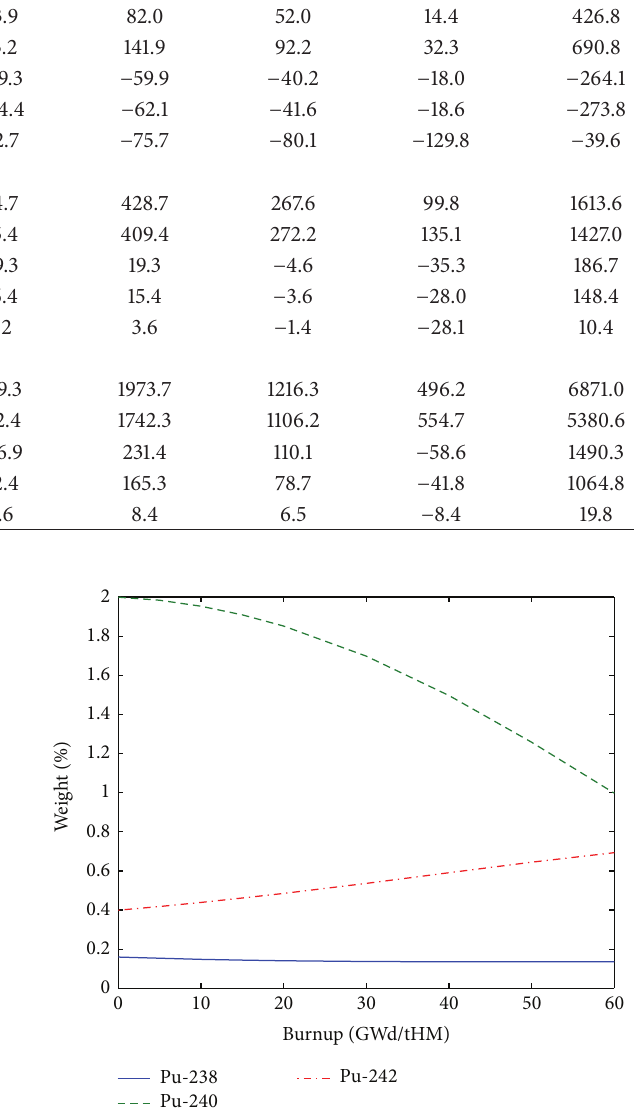
Figure 13: The amount of Pu-238, Pu-240, and Pu-242 in the Th- MOX fuel